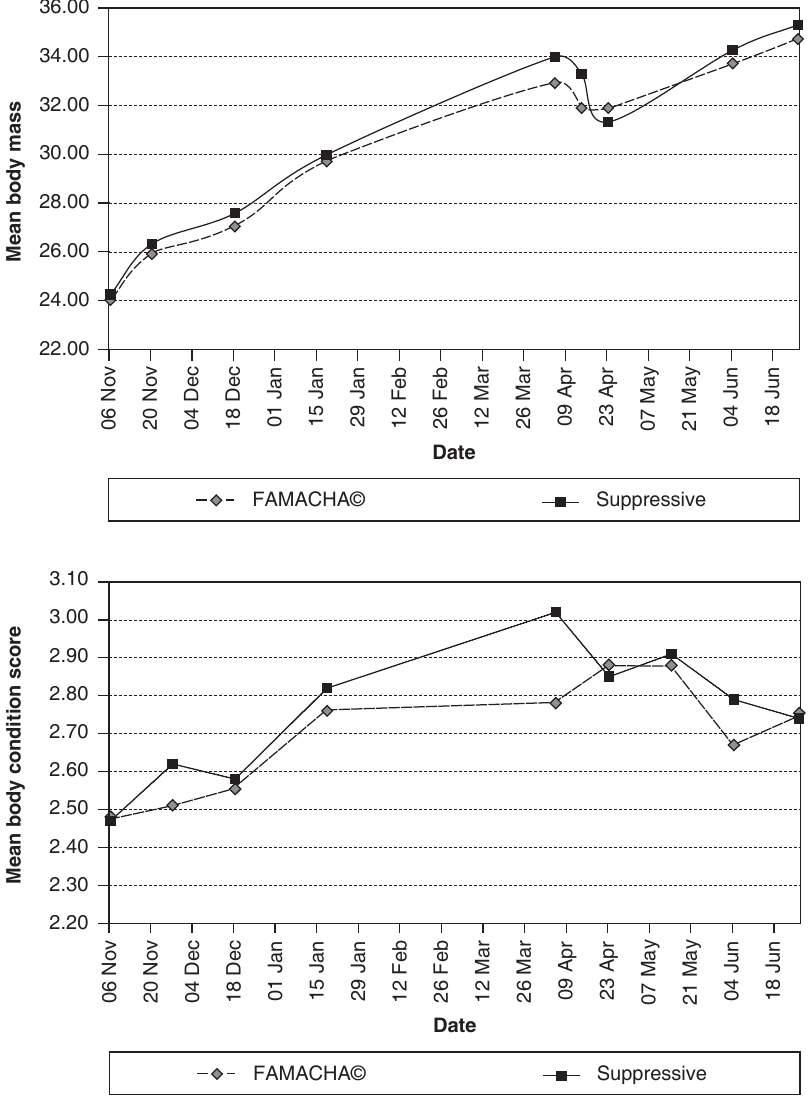
FIG. 1 Experiment 1 (Farm 1, wethers in re placement ram flock): Mean body mass